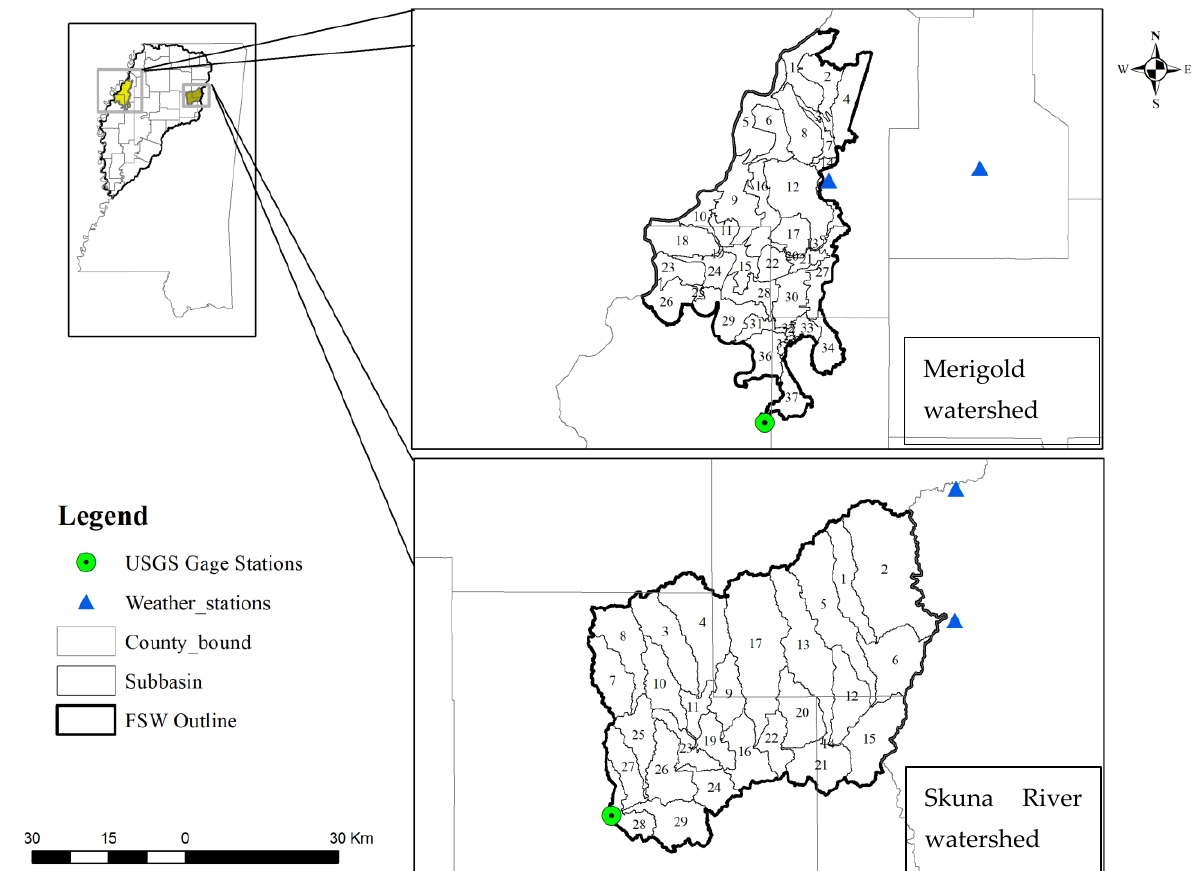
Figure 1. Study area with field ( right ) and large ( left ) scale watersheds including sub-watershed numbers, weather stations, and USGS monitoring stations; Yazoo River Watershed ( upper left ), field-scale watersheds: Merigold Watershed ( top right ), and Skuna River Watershed ( bottom right ).